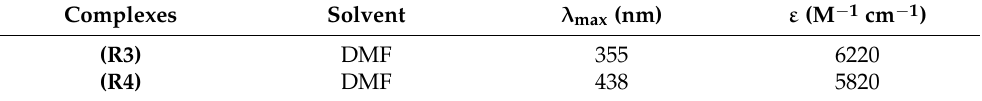
Table 1. Molar extinction coefficients ε in different solvents for the Cu-complexes investigated.